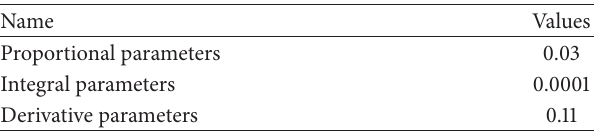
Table 3: PID controller parameters for air bearing testing. Table 4: AFSMC controller parameters for air bearing